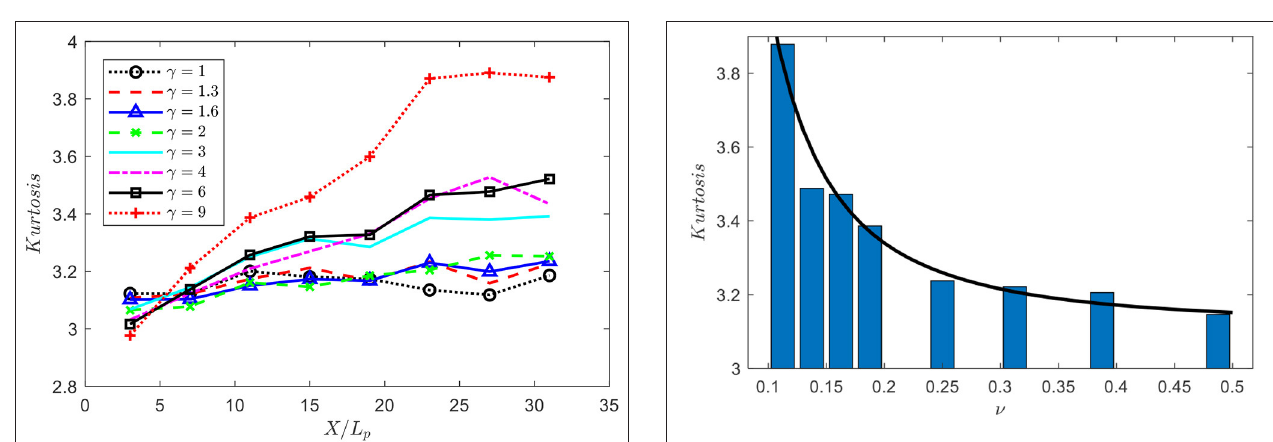
excess kurtosis is in proportion to the inverse of ν 2 ,